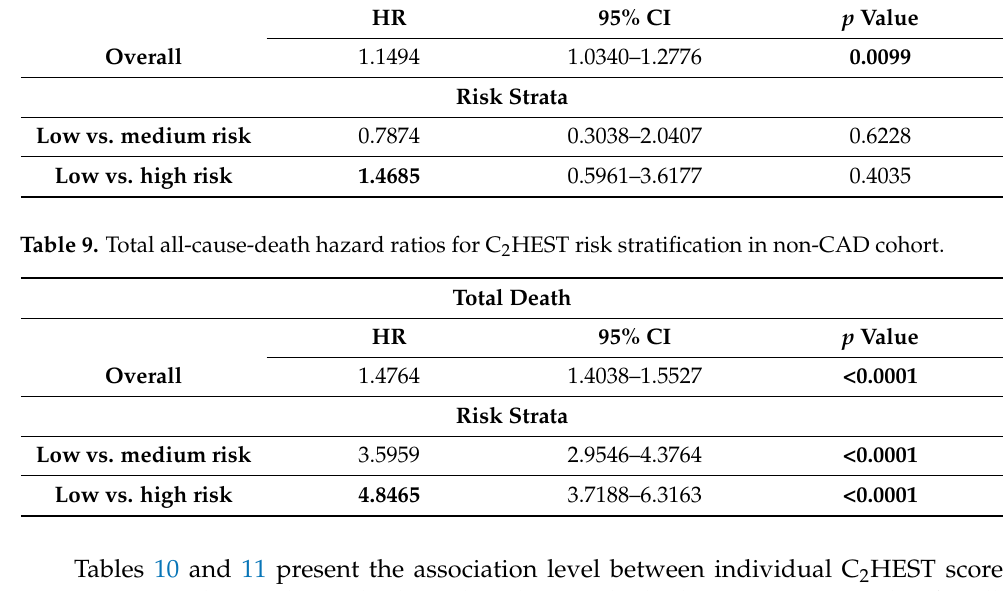
Figure 3. Survival curves for the C 2 HEST strata in both study cohorts estimated by Kaplan– Meier function.